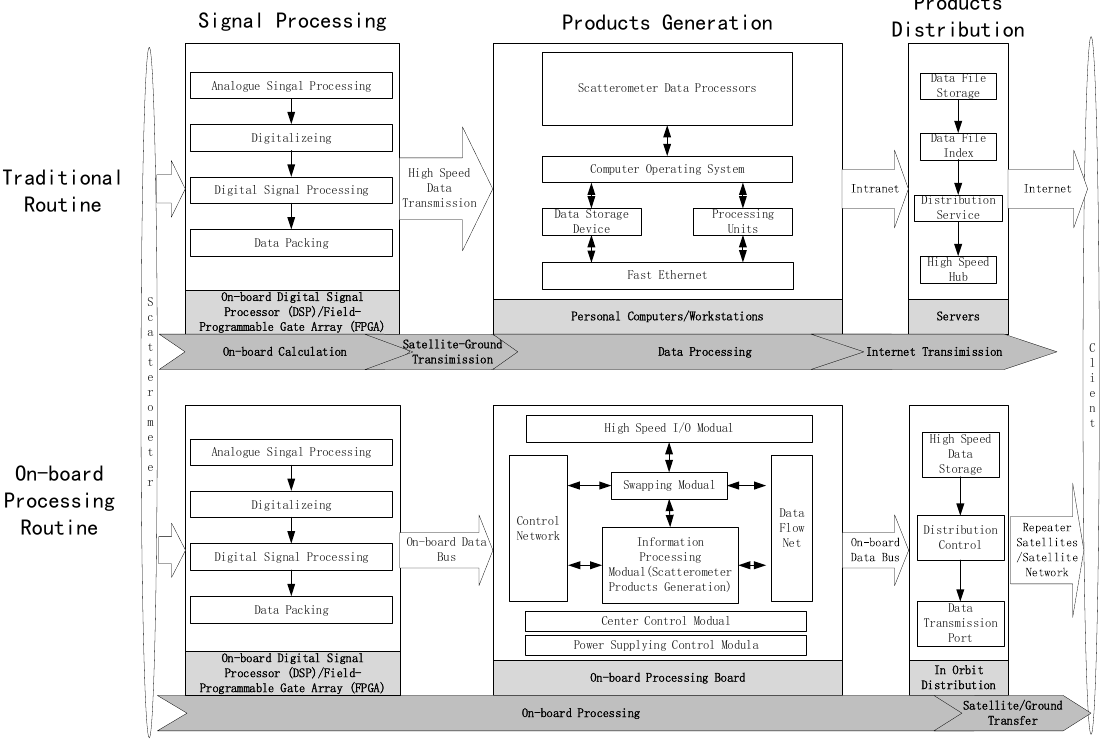
Figure 1. Comparison of traditional and the proposed on-board processing routines.